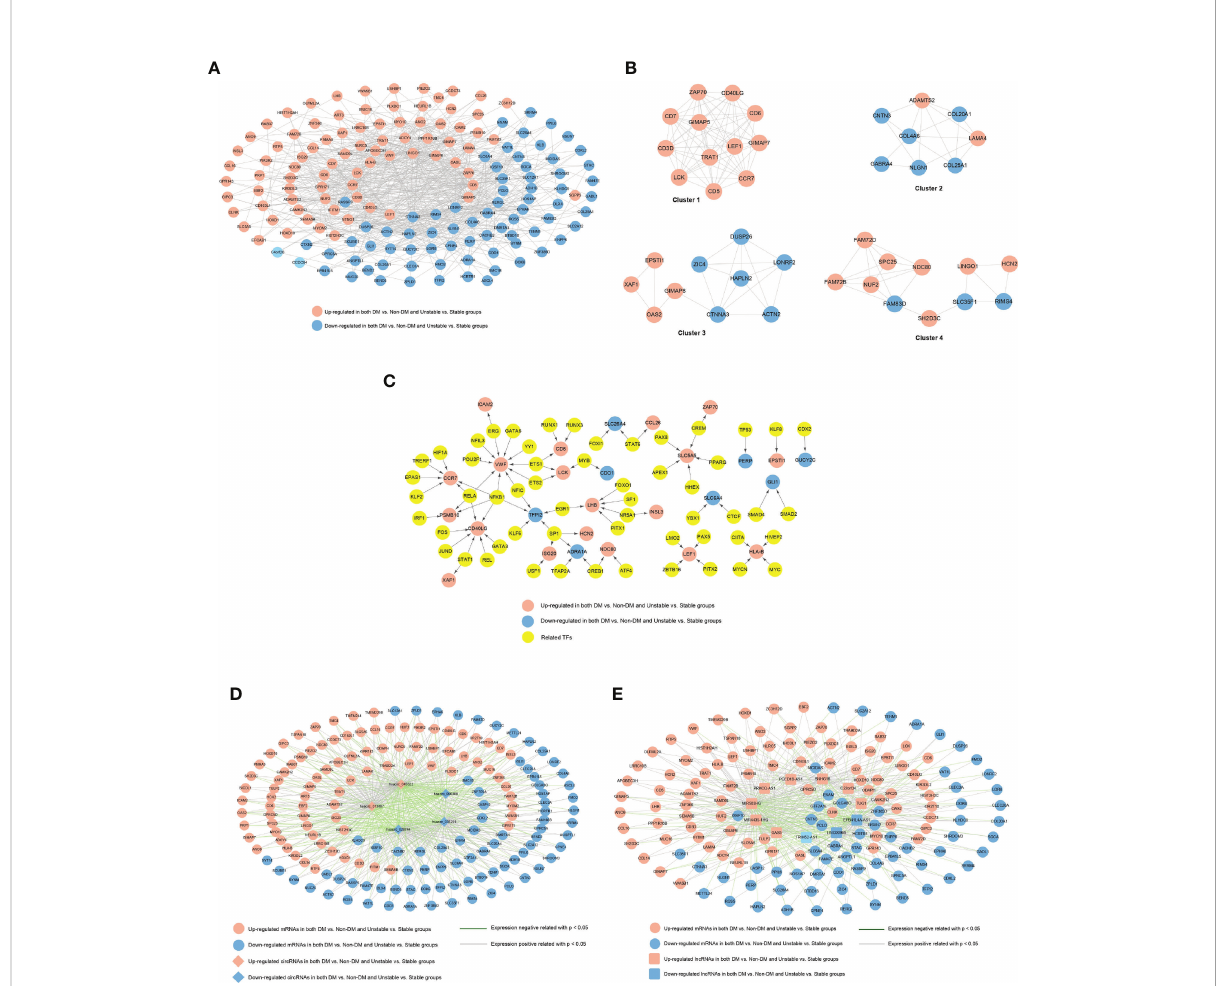
FIGURE 4 (A) PPI network of signi fi cantly differentially expressed genes. The red and blue nodes represent the genes that are signi fi cantly upregulated and downregulated, respectively, in the two comparison groups. (B) Interaction network module diagram. The red and blue nodes represent the genes that are signi fi cantly upregulated and downregulated, respectively, in the two comparison groups. (C) TF-differential gene regulatory network. The yellow square and circle represent TFs and signi fi cantly differentially expressed genes, respectively, and the red and blue nodes represent the genes that are signi fi cantly upregulated and downregulated, respectively, in the two comparison groups. (D) circRNAs-miRNA co- expression network, red and blue represent the RNAs that are signi fi cantly upregulated and downregulated, respectively, in the two comparison groups, and round and diamond represent mRNAs and circRNAs, respectively; The blue and gray lines indicate signi fi cant negative and positive correlations, respectively. (E) lncRNA-miRNA co-expression network, red and blue represent the RNAs that are signi fi cantly upregulated and downregulated, respectively, in the two comparison groups, and round and square respectively represent mRNAs and lncRNAs; The blue and gray lines indicate signi fi cant negative and positive correlations,